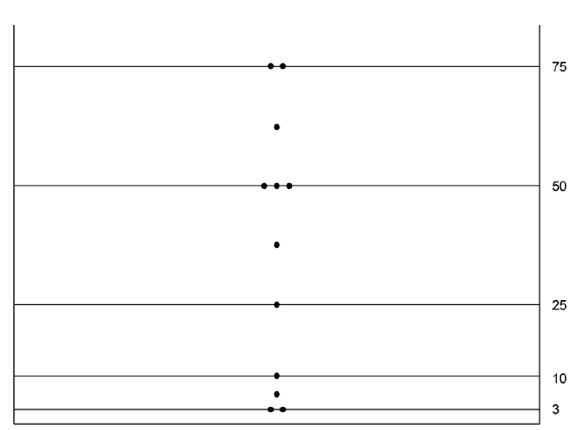
Figure 3: Percentile weight distribution of infants with NEC stricture (Note: no infants had IUGR) NEC was diagnosed in this cohort at a median of 2 (range 1 - 47) days after birth. The median peak C- reactive protein (CRP) level during the acute phase of the NEC was 73.1 (range 25.2 - 232)